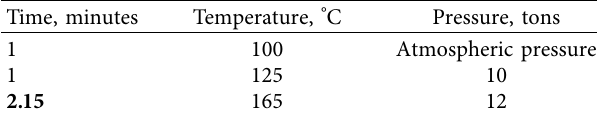
Table 4: Details of the cure and pressure cycle followed. Time,